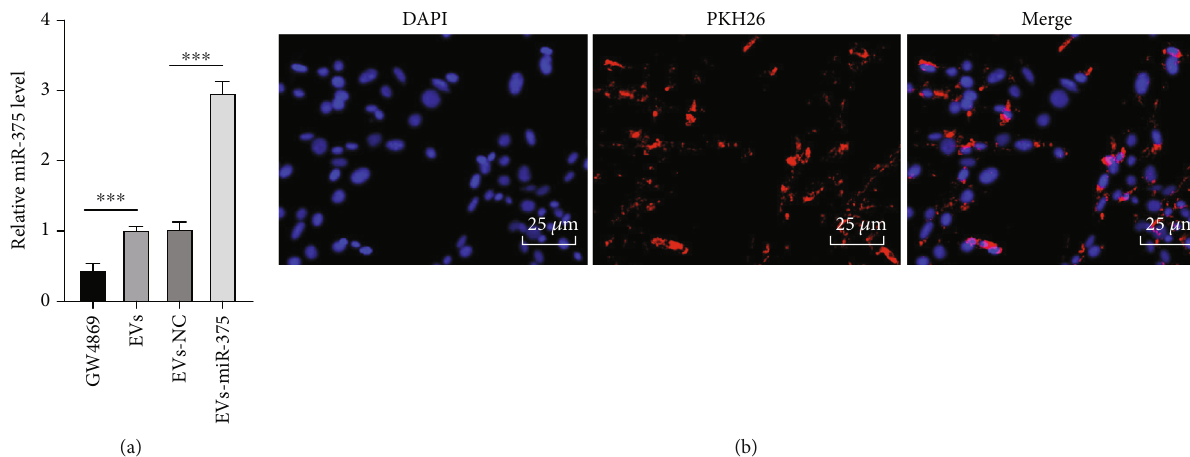
Figure 3: ADSC-EVs are internalized by fBMFs. fBMFs were treated with 100 μ g ADSC-EVs for 24 h. (a) miR-375 expression in fBMFs was detected using RT-qPCR. (b) The internalization of EVs-miR-375 by fBMFs; fBMF nuclei were labeled with DAPI (blue) and EVs-miR-375 were labeled with PKH26 (red). GW4869: treatment of ADSC conditioned medium supplemented with EV inhibitor GW4869; EVs: treatment of ADSC-EVs; EVs-miR-375/EVs-NC: treatment of EVs derived from ADSCs transfected with miR-375 mimic or NC mimic. The experiment was repeated 3 times, and the data were expressed as mean ± SD . Comparison among groups was analyzed using one-way ANOVA followed by Tukey ’ s multiple comparisons test. ∗∗∗ P < 0 : 001